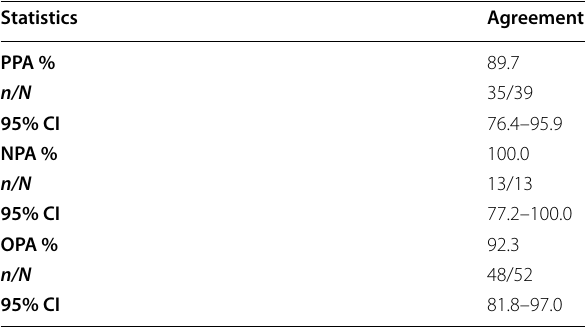
Table 5 Agreement between TAP (5% cutoff) and CPS (cutoff of 1) scoring